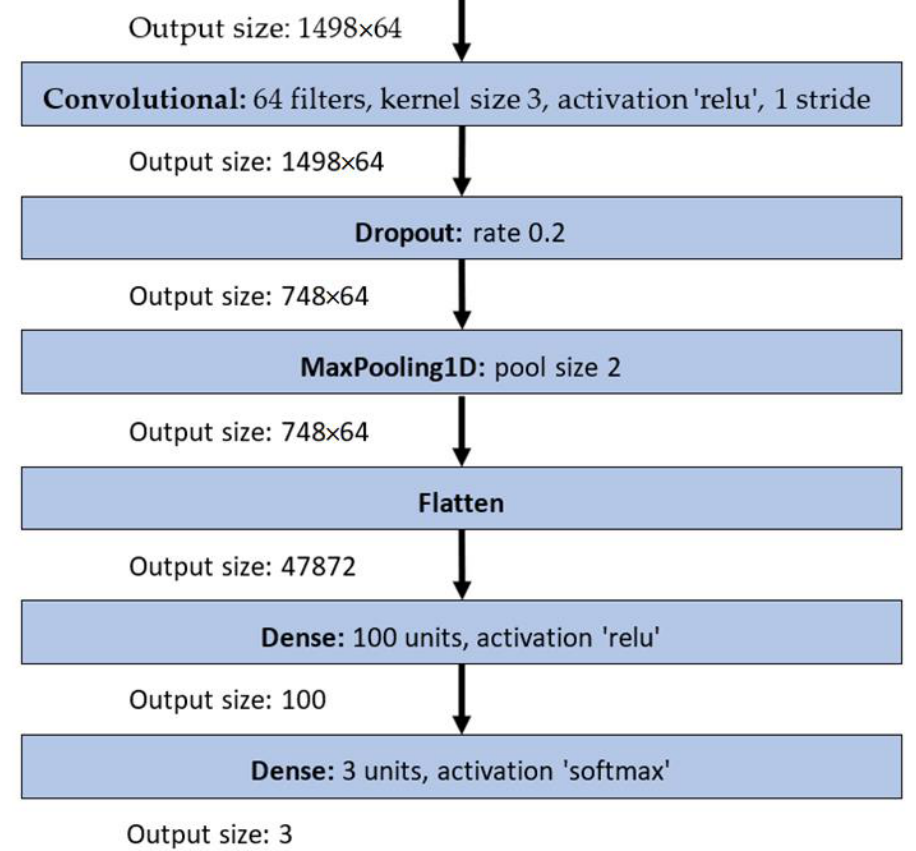
Figure 4. CNN2 architecture.